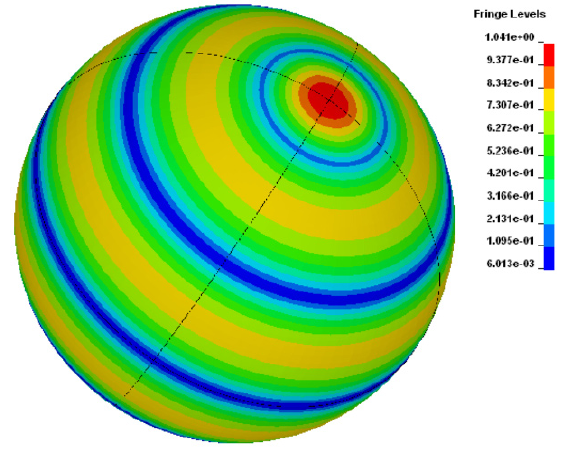
Figure 8. Deformation of the shell at t = 700 µs ( w